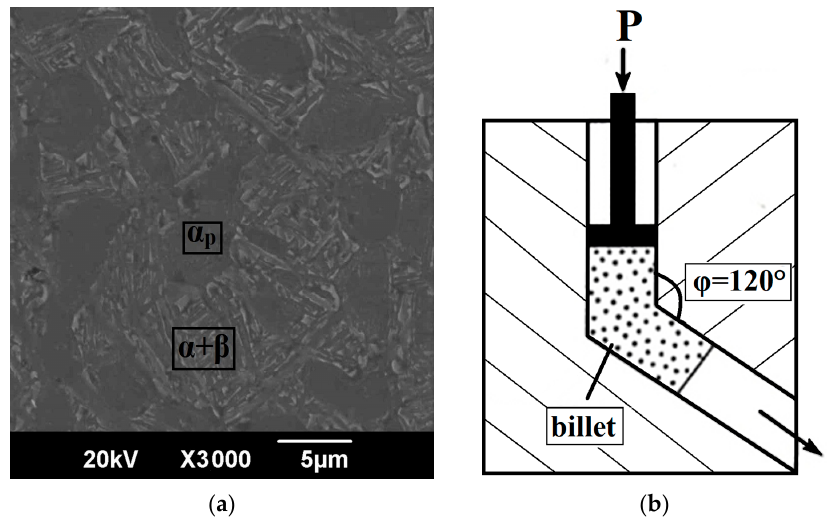
Figure 1. Equal-channel angular pressing: ( a ) microstructure of the billet; ( b ) principle of ECAP. A UFG state was produced by severe plastic deformation: a billet with a length of 100 mm (in the direction along the X axis, Figure 2a) was subjected to 4 passes of equal-chan- nel angular pressing (ECAP) with a channels intersection angle of 120° (Figure 1b), fixed in the die, via route C at a temperature of 700 °C, i.e., with 180° rotation after each pass along the longitudinal axis (0°–180°–0°–180°). The true strain introduced into the material was 2.8. To simulate the process of shape forming of a part, the upsetting of the billets with a UFG structure was conducted in the direction along the Z axis at a temperature of 750 °C ( ε = 30%). Figure 2 shows the principle of cutting out samples from the produced billets with a UFG structure for further study.